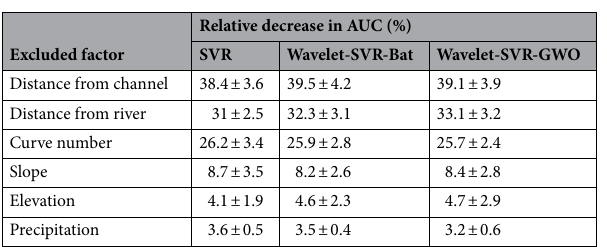
Table 4. Overall importance of predictors in the three models